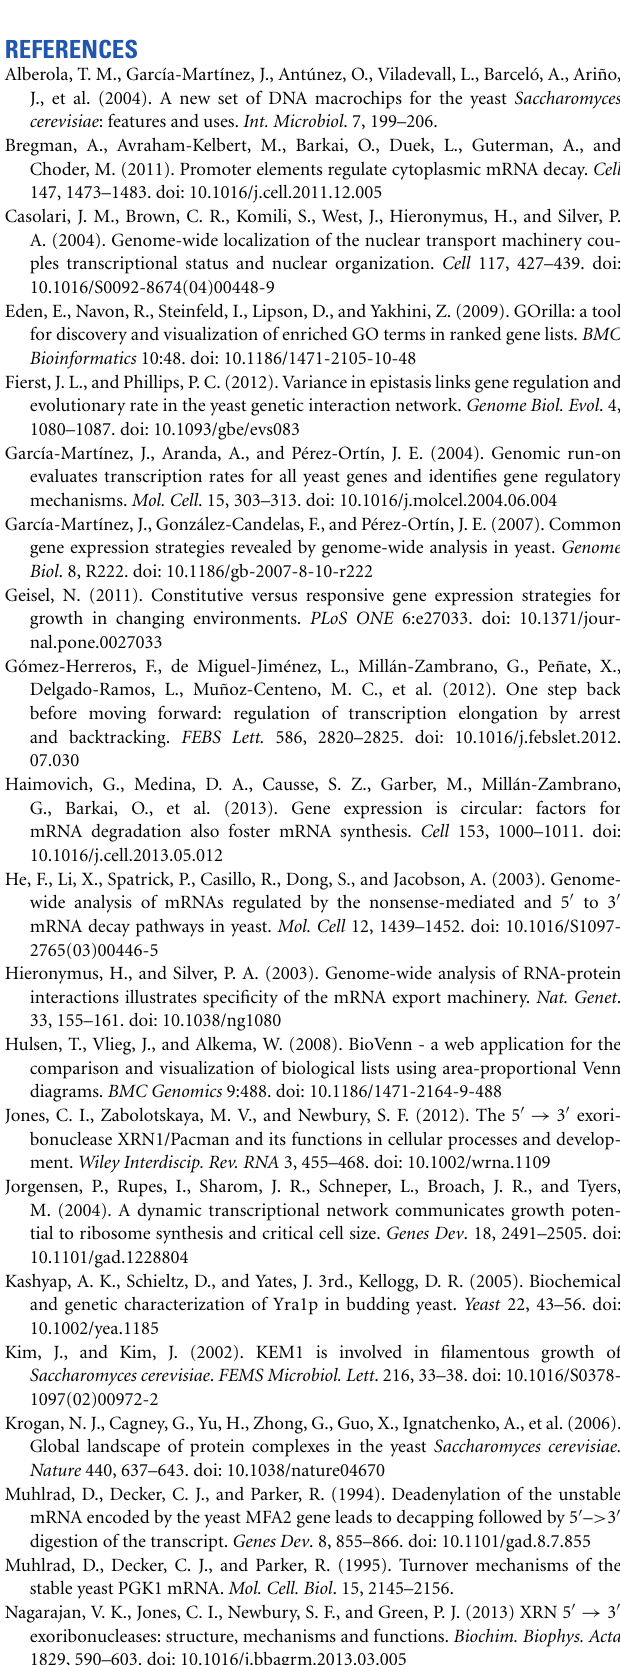
the xrn1 mutants. The responsiveness index is also